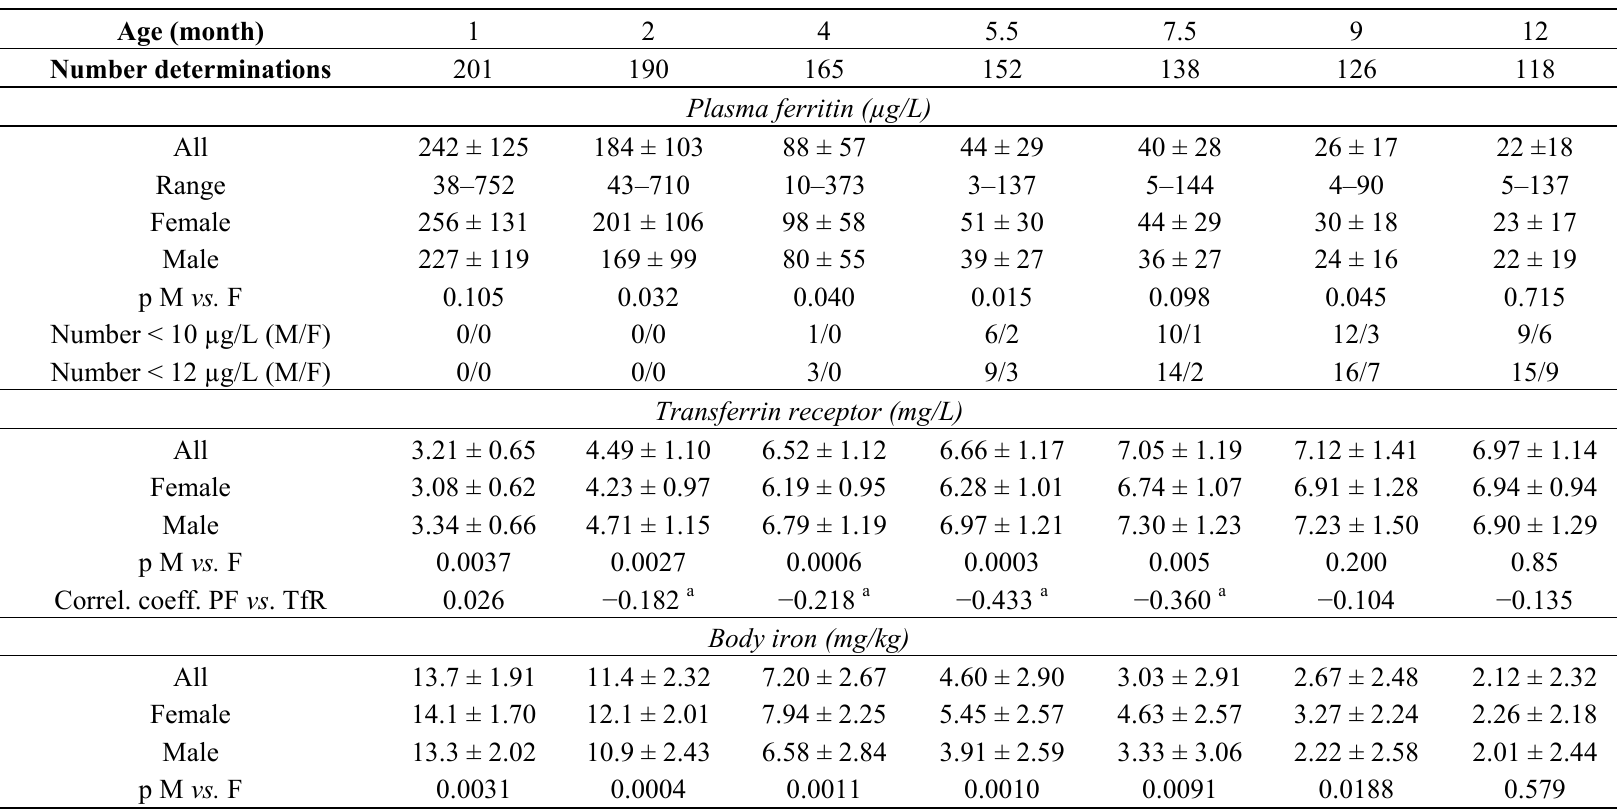
Table 2. Plasma concentrations of ferritin (PF) and transferrin receptor (TfR). Values are mean ± SD unless otherwise